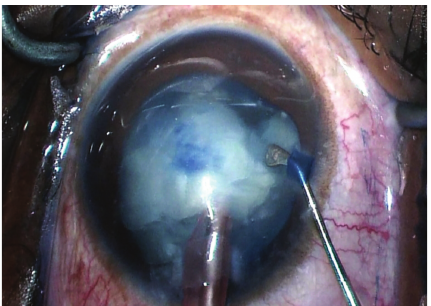
Figure 3: This photo demonstrates a lens fragment that flipped as it was being emulsified. Note the trypan blue staining on the formerly posterior surface of the lens fragment. This suggests that the Argentinian flag allowed access of the trypan blue to the anterior surface of the posterior capsule.